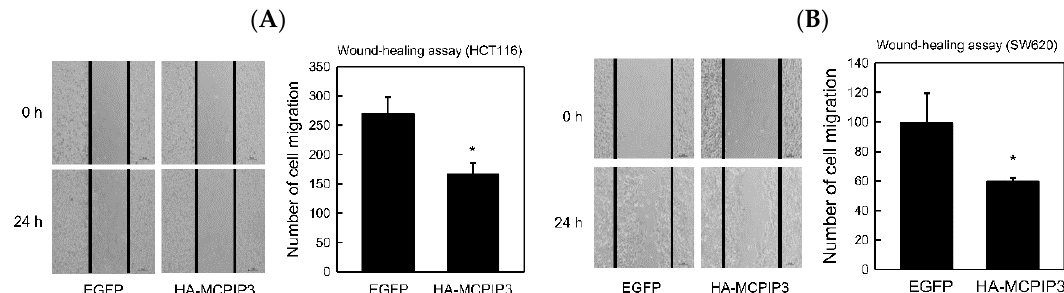
Figure 5. Effects of MCPIP3 overexpression on the cell migration of human HCT116 and SW620 colorectal cancer cells. ( A ) HCT116 and ( B ) SW620 cells were transduced with lentiviral vectors (at an MOI of 3) expressing the indicated enhanced green fluorescent protein (EGFP; as a control) and HA-MCPIP3 for 48 h, and the cell migration of equal amounts of transduced cells was examined by a wound-healing assay (magnification ×200) for 24 h. Each value represents the mean ± SE from three independent experiments. * p < 0.05 vs. EGFP control cells.